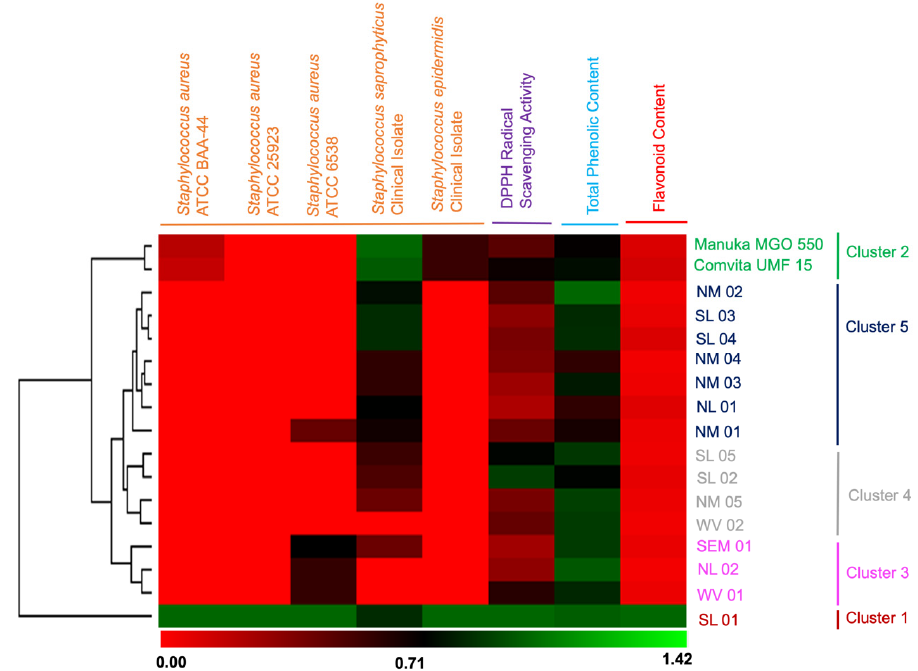
Figure 2. Heat map and hierarchical clustering presentation of antibacterial activity, antioxidant activity, total phenolic content, and flavonoid content of honey crude extract samples.